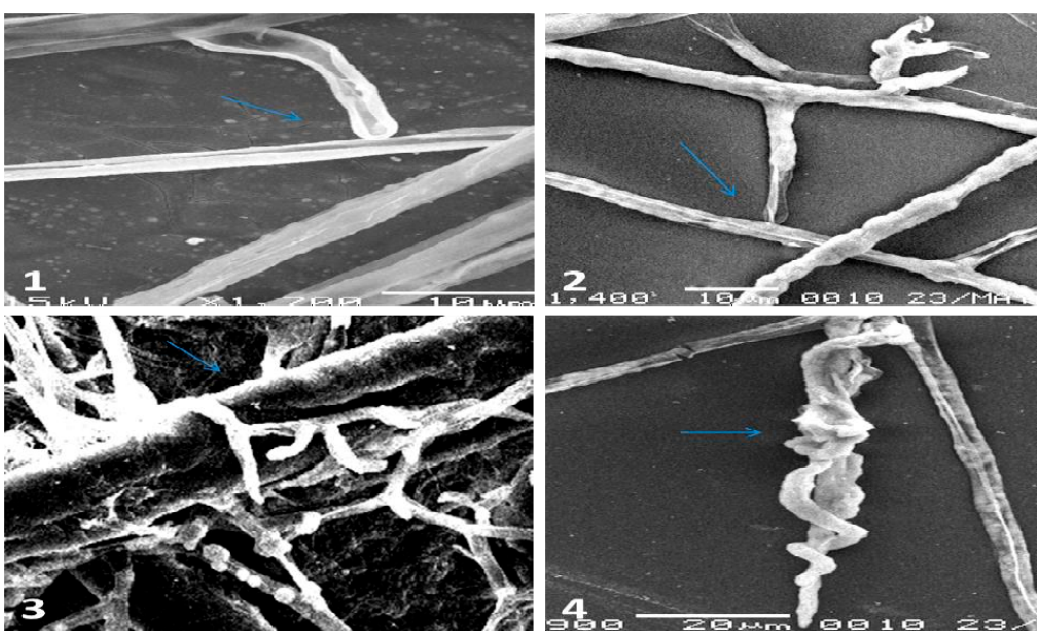
Figure 2. Hyphal interactions between P . oligandrum ( MS15 ) and P . aphanidermatum using a light microscope: ( 1 ) and ( 2 ) showing infection pegs of P. oligandrum ; ( 3 ) and ( 4 ) showing hyphae of P . oligandrum grow inside hyphae of P . apha- nidermatum ; ( 5 ) and ( 6 ) arrows pointed to P. oligandrum twisted on hyphae of P . aphanidermatum .